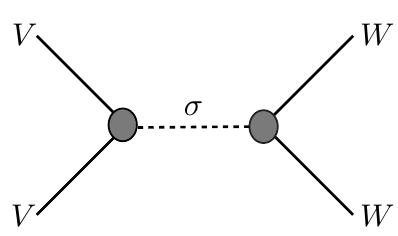
Figure 1 . At leading order in large N correlation functions are controlled by exchange of hydro- dynamic fields σ ( t )